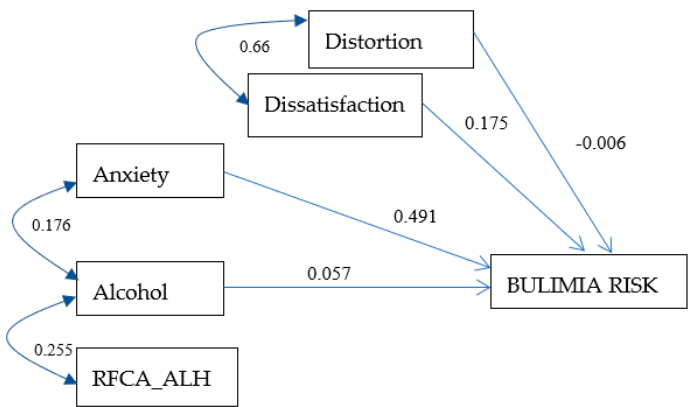
Figure 3. Bulimia risk model for men. The values on one-headed arrows are the standardized regression weights and those on each two-headed arrow are the correlations for the model. The shapes in the diagram are defined as follows: small ovals are measurement or prediction errors; rectangles, measured variables. RFCA_ALH: food restriction after consuming alcohol. X 2 = 14.256, p = 0.075, CFI = 0.977, PNFI = 0.507, RMSEA = 0.055, and R 2 = 0.284.